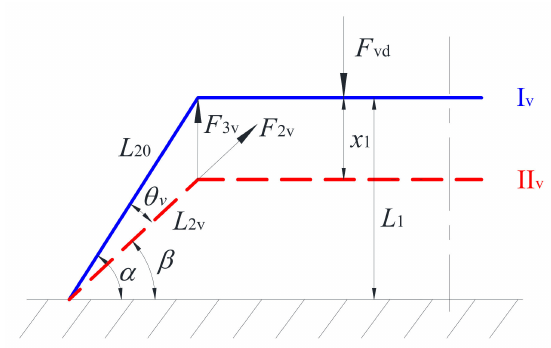
Figure 5. Schematic diagram of vertical